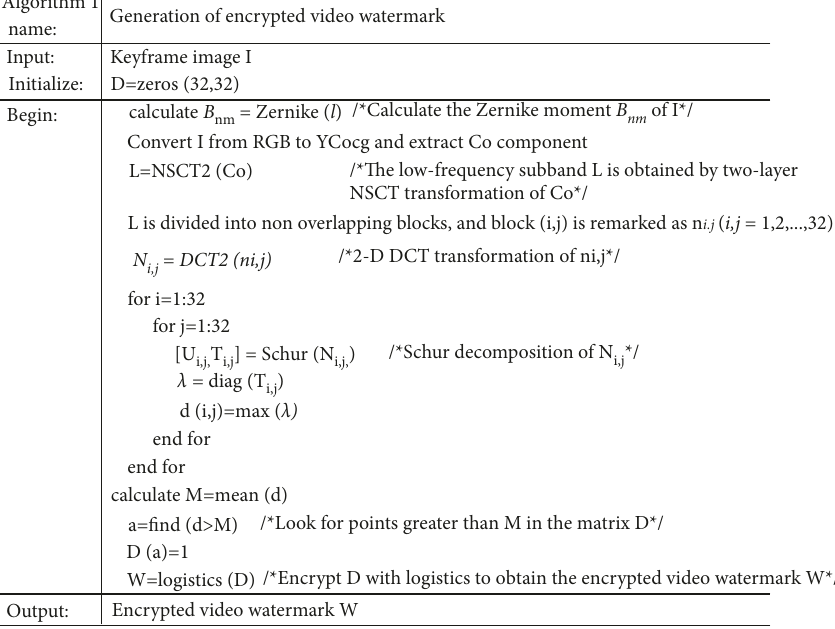
Figure 3: Pseudocode of generating algorithm of encrypted video